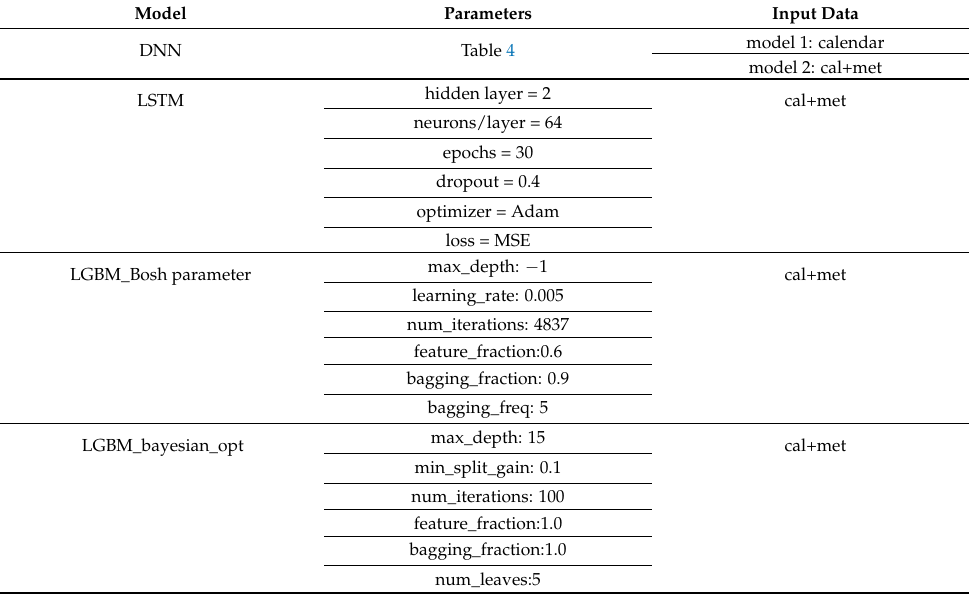
Table 3. Parameter and model configuration for methods used in our study.